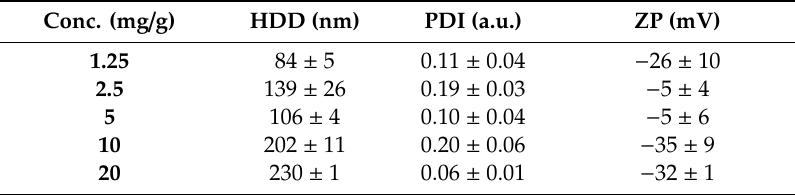
Table 1. Physico-chemicalcharacteristicsofnanoparticlesmadewithdifferentPMVE /